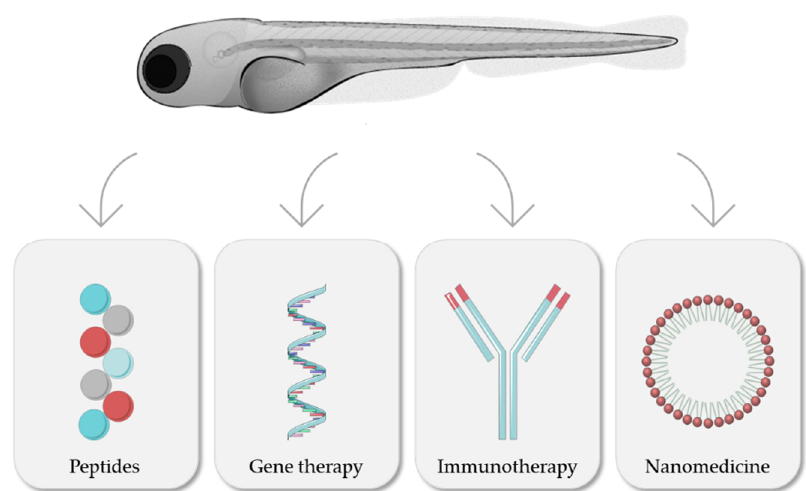
Figure 4. Zebrafish as a model for evaluation of different cancer treatments. Modified from Servier Medical Art (https://smart.servier.com; accessed on 3 March 2022), licensed by a Creative Commons Attribution 3.0 Unported License, and Lizzy Griffiths.